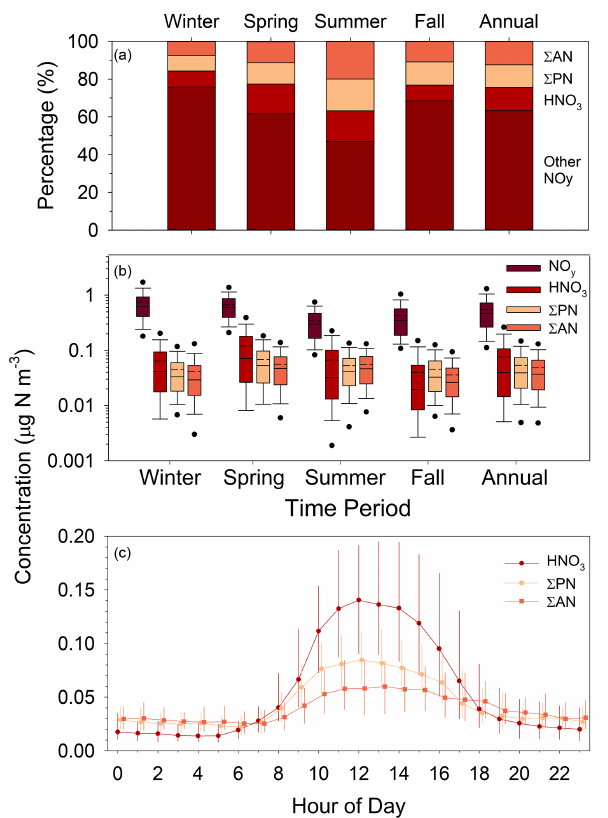
Figure 5. Seasonal and annual percent contribution of HNO 3 , (cid:54) PN, (cid:54) AN, and other compounds to total NO y (a) ; seasonal and annual box plots of NO y , HNO 3 , (cid:54) PN, and (cid:54) AN – solid and dashed lines inside the box represent the median and mean, respectively; the top and bottom of the box represent 75th and 25th percentiles; whiskers represent 10th and 90th percentiles, and dots represent 5th and 95th percentiles. (b) Diurnal profiles of HNO 3 , (cid:54) PN, and (cid:54) AN – obser- vations represent median hourly concentration, and bars represent interquartile range (c) . “Other NO y ” is calculated as NO y –HNO 3 – (cid:54) PN– (cid:54) AN, which, while primarily comprised of NO x , includes N 2 O 5 , HONO, NO − , and possibly other 3